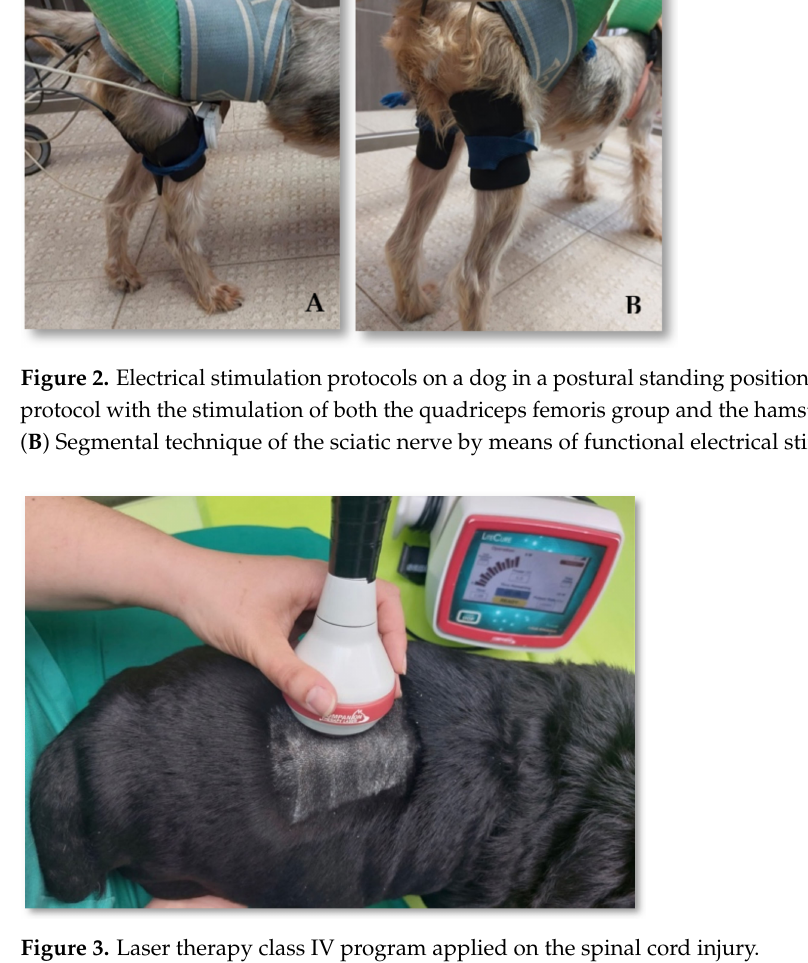
Figure 3. Laser therapy class IV program applied on the spinal cord